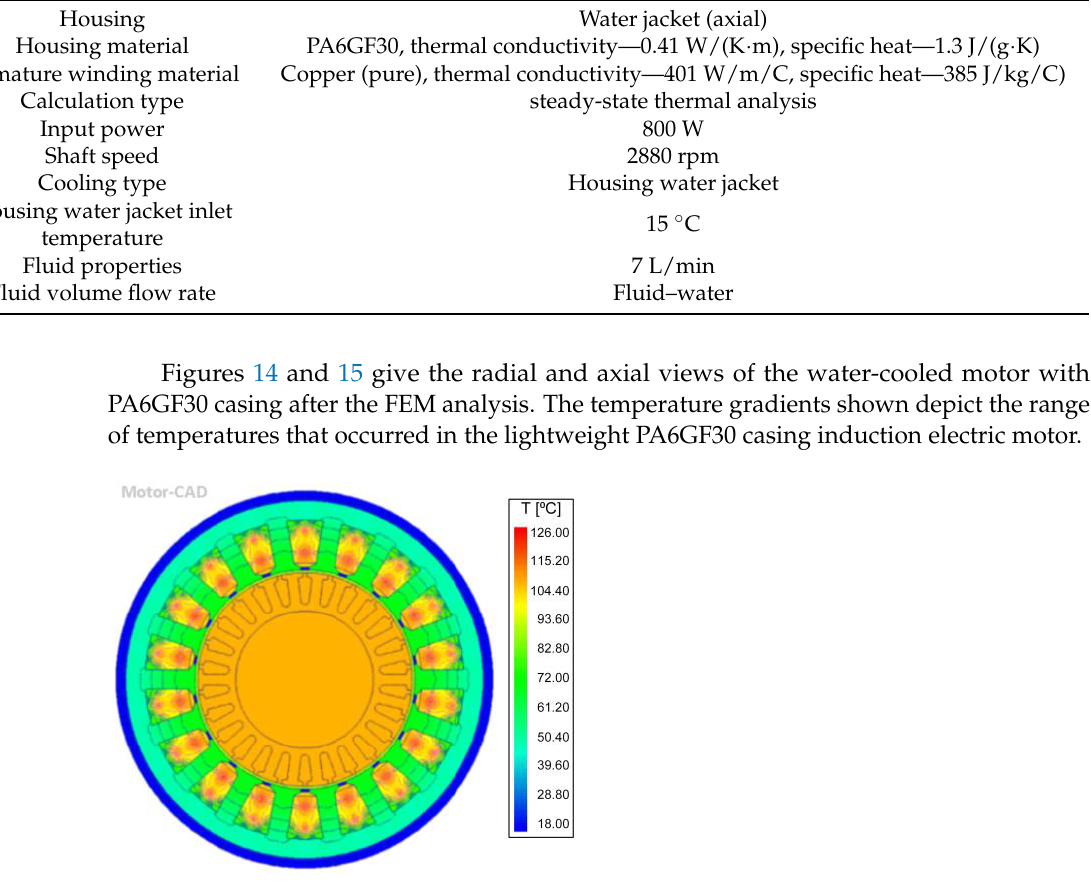
Figure 14. Radial view of PA6GF30 casing electric motor (water-cooled after FEM analysis).